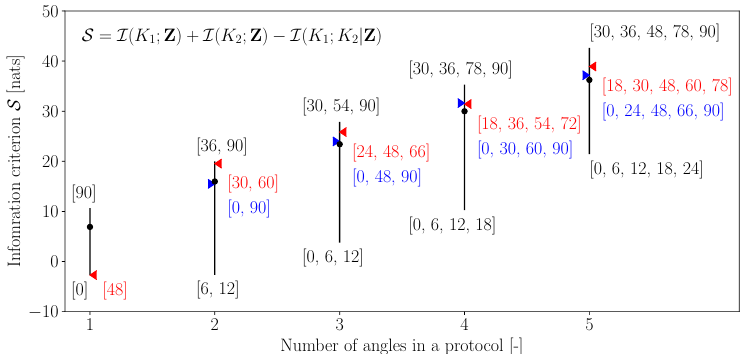
= ( K ) + ( K ) ( K ) across the 2 ; Z 1 ; Z 1 ; K 2 | Z S I I − I . The red and blue pointers show for angle S S